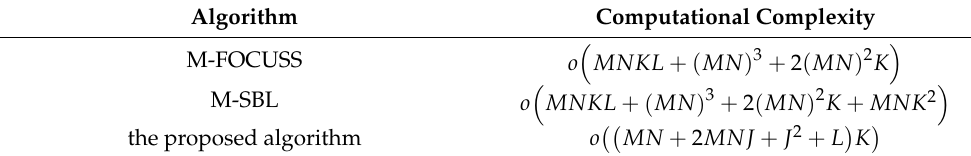
Table 1. The computational complexity for a single iteration. Algorithm